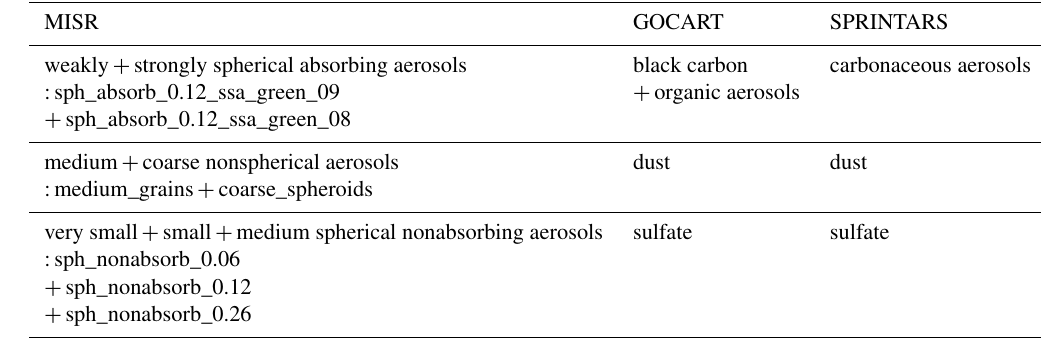
Table 1. Combination of AOD by components for comparison of MISR with the GOCART and SPRINTARS models. The names of aerosol components in MISR are from Table 1 in Kahn et al.